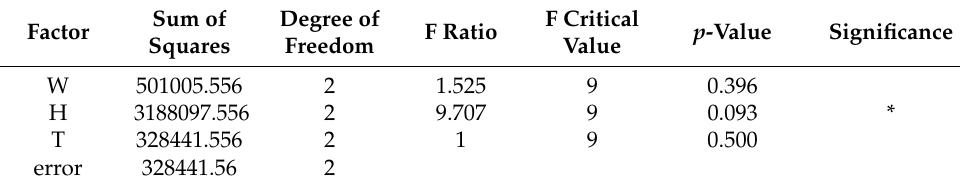
Table 19. The variance of MOE of impregnated heat-treated